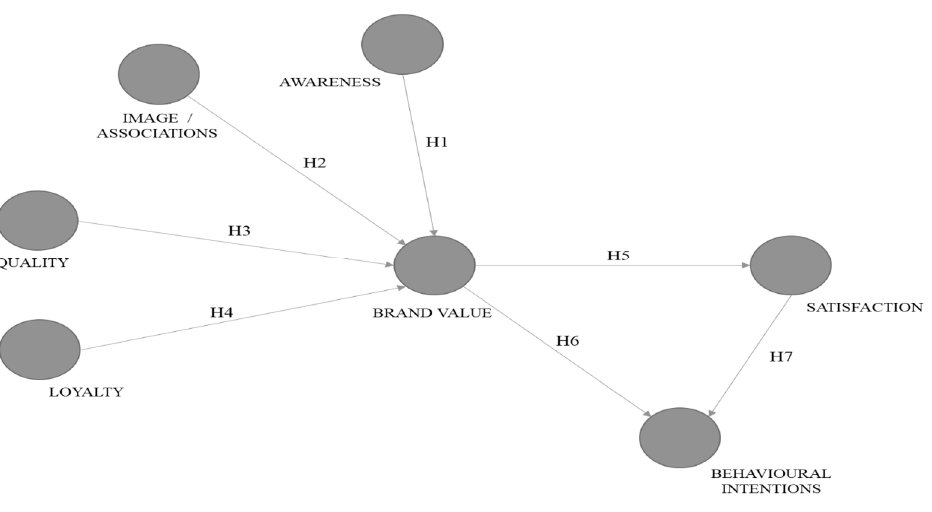
Figure 1. Structural model. Source: Own